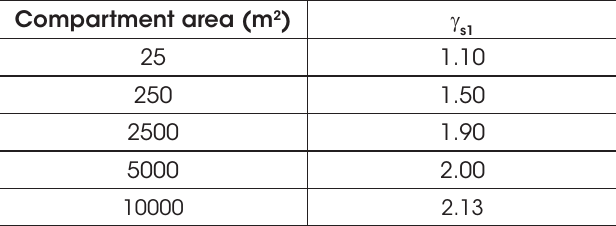
Values of γ in function of the compartment area s1